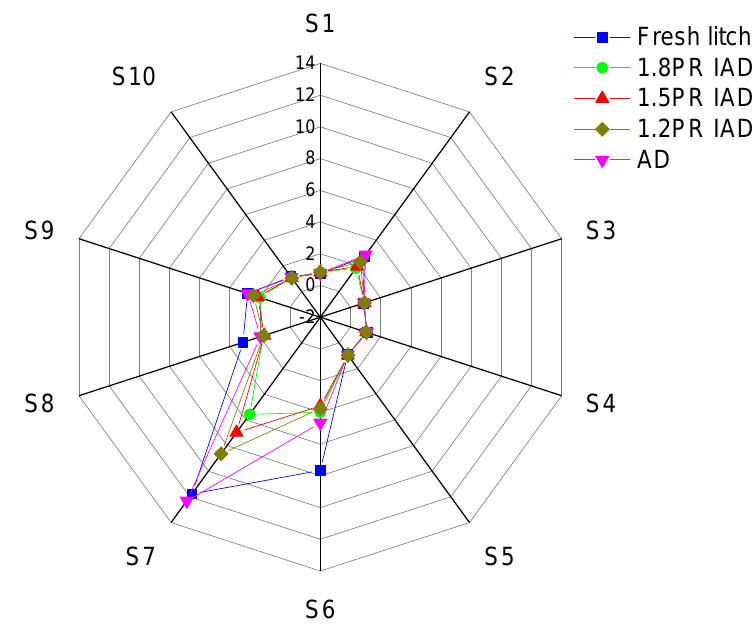
Figure 6. E-nose evaluation of litchi dried by drying schemes with di ff erent pulse ratios. Note: AD is continuous air drying; the ratio 1.2 PR is an on 20 min and o ff 5 min pulse of intermittent air